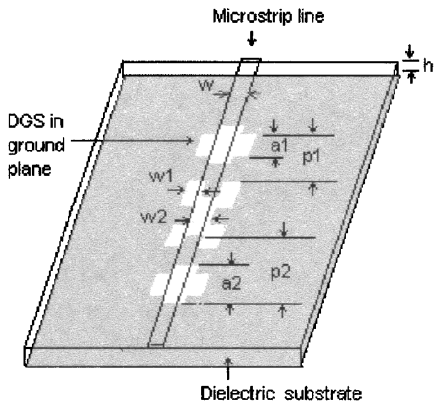
FIGURE 1 Three-dimensional view of one of the proposed